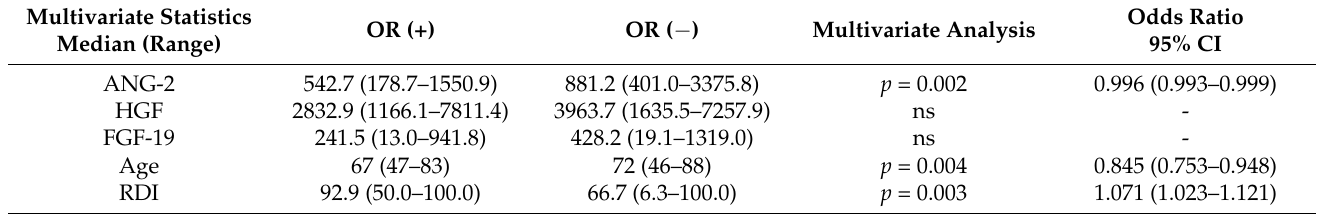
Figure 2. Comparison of baseline growth factors between patients with or without objective response (OR). Baseline serum FGF-19, ANG-2, HGF, EGF, and VEGF levels were compared between patients with or without an OR. Asterisks indicate statistically significant differences (* p < 0.05, *** p <0.001, ns: not significant). FGF-19, fibroblast growth factor-19; ANG-2, angiopoietin-2; HGF, hepatocyte growth factor; EGF, epidermal growth factor; VEGF, vascular endothelial growth factor. Table 2. Multivariate analysis for the factors associated with objective response (OR).